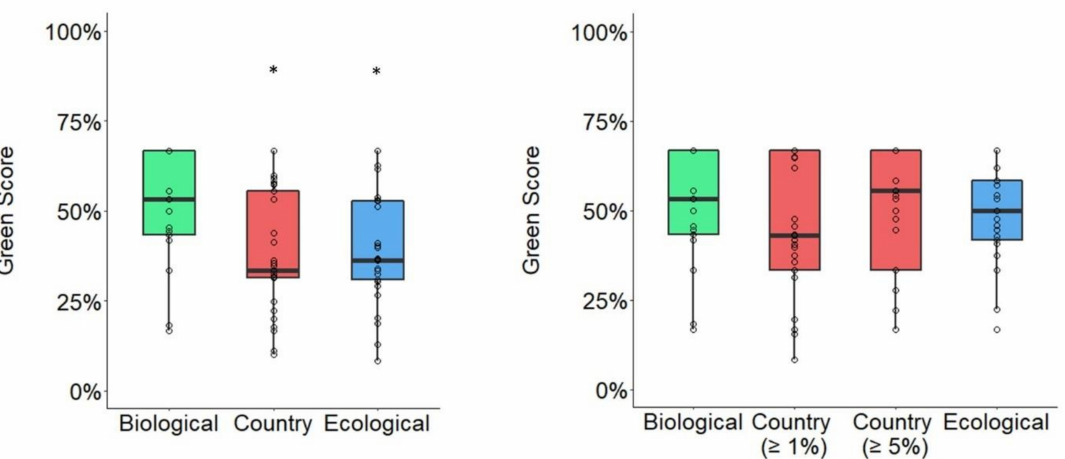
Figure 3. Boxplots showing Green Scores for 29 species of European mammals and birds generated using different methods of dividing the baseline distribution into spatial units. Center bars show median values, while asterisks represent means significantly different from the mean for the biological method (beta regression; see text). ( Left ): Green Scores from biologically based spatial units compared with finer alternative spatial unit delineation methods (all countries within the baseline distribution treated as a separate spatial unit and ecological spatial units based on ecoregions). ( Right ): Green Scores from biologically based spatial units compared with coarser alternative spatial unit delineation methods (only countries comprising ≥ 1% or ≥ 5% of the baseline distribution area treated as spatial units, and ecological spatial units based on